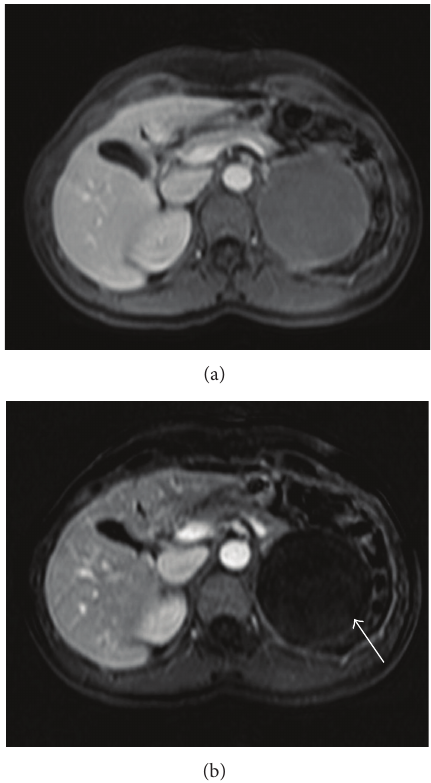
Figure 4: Fat suppressed T1-WI following administration of intra- venous gadolinium-based contrast material (a) and subtracted image (b) show lack of